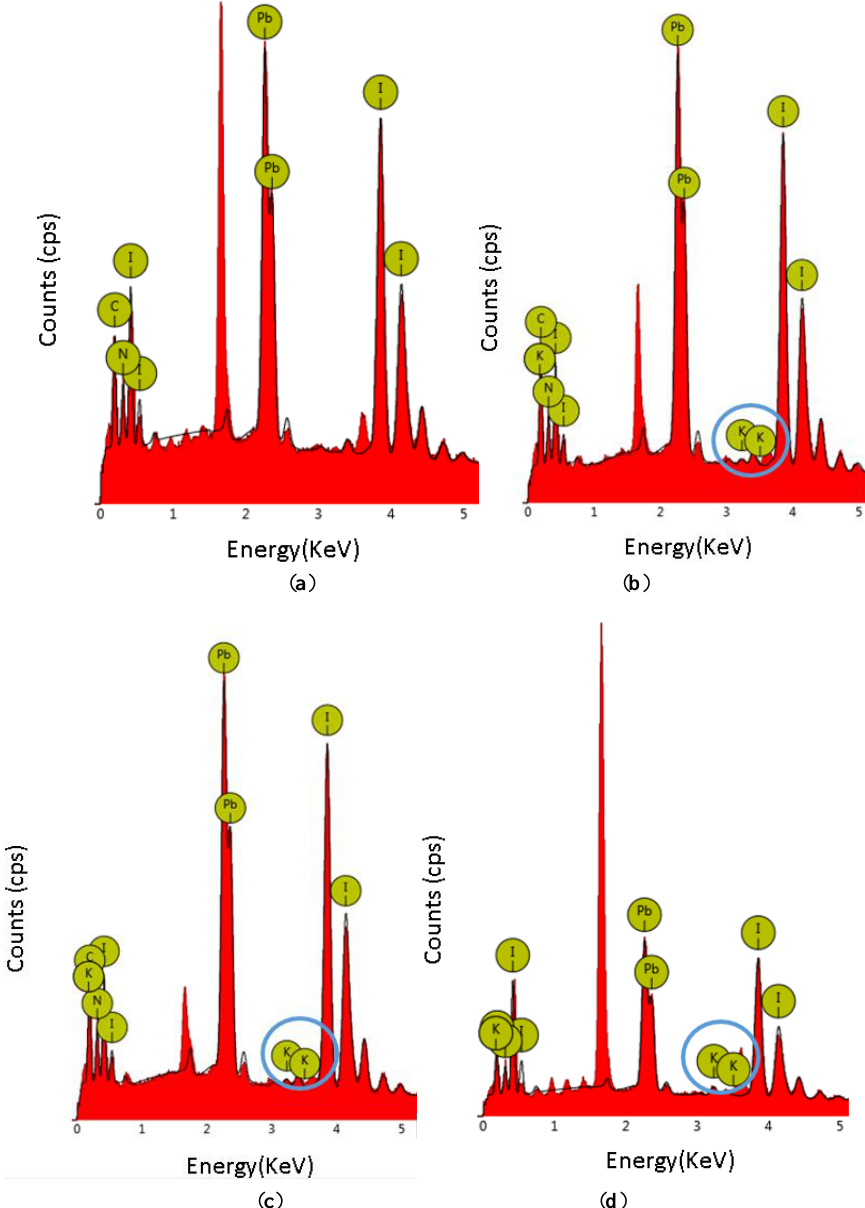
Figure 4. The EDS of perovskite films with different K + concentrations: ( a ) MAPbI 3 ; ( b ) MAPbI 3 + 0.04KI;